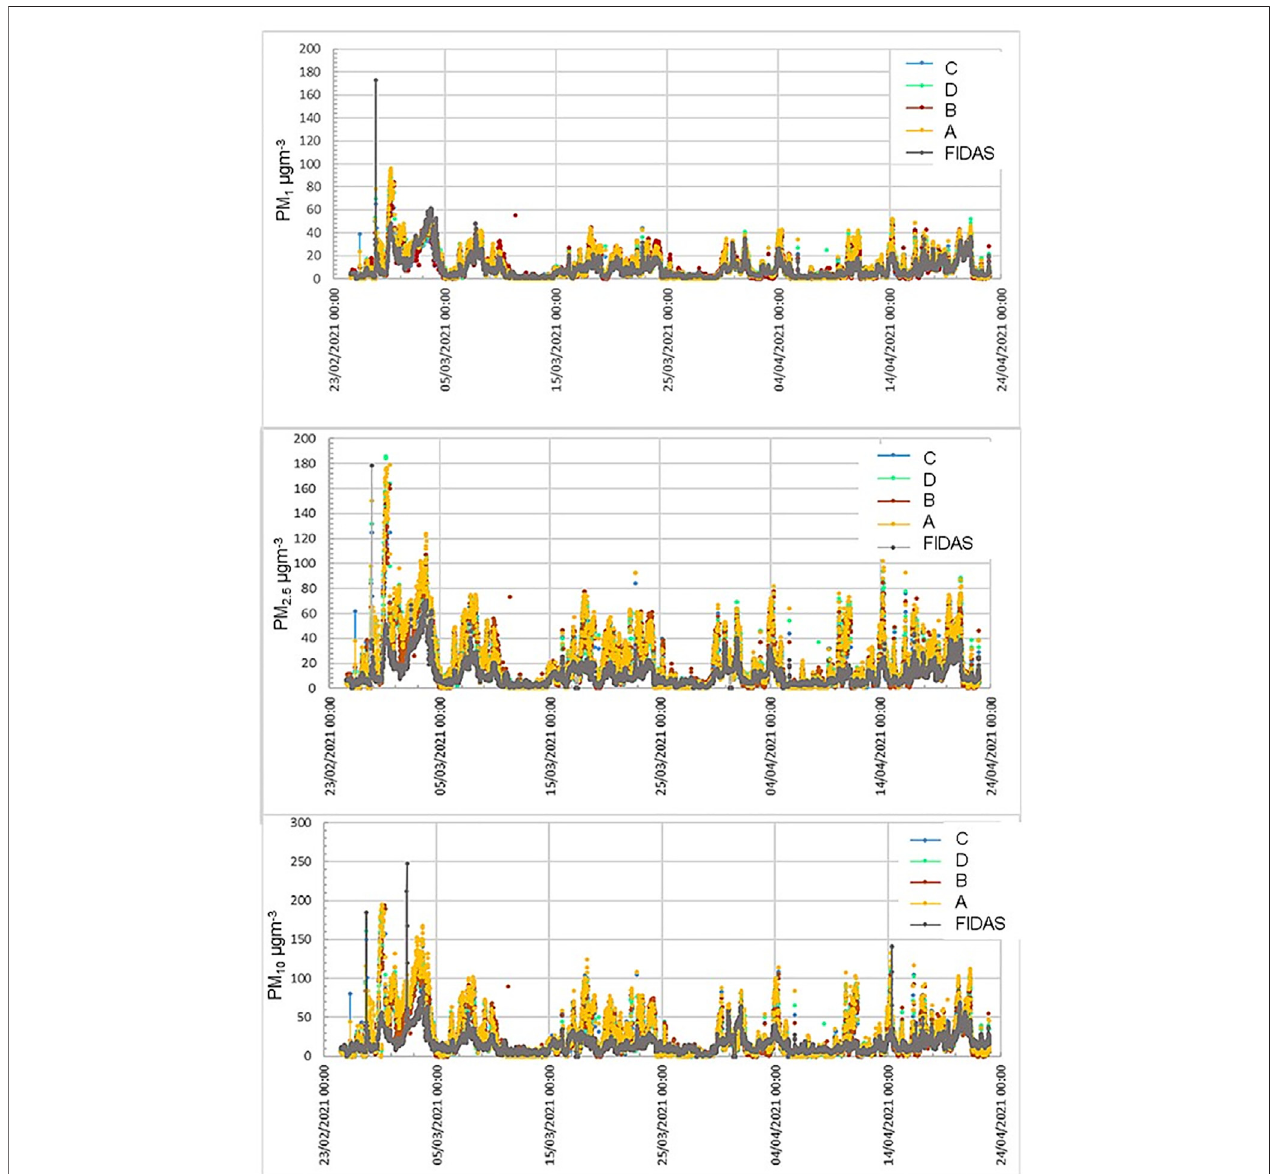
FIGURE 1 | Hourly average time plot of low-cost sensors against the Birmingham Air Quality Supersite FIDAS.